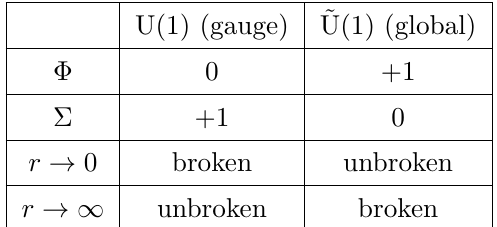
Table 1 . The quantum charges of scalar fields and the symmetry configuration. The global symmetry is restored at r → 0 and the gauge U(1) is broken around r ∼ 0 due to the existence of